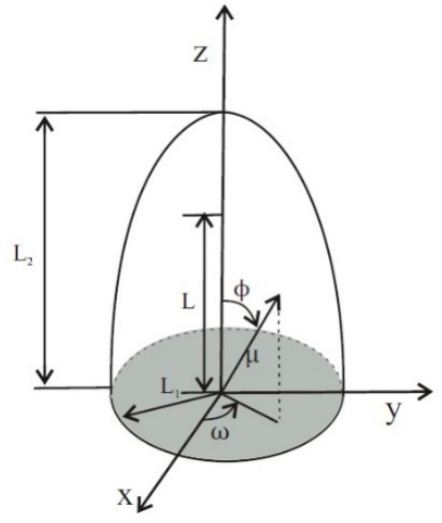
Figure 2. Geometrical parameters of a prolate spheroidal solid.